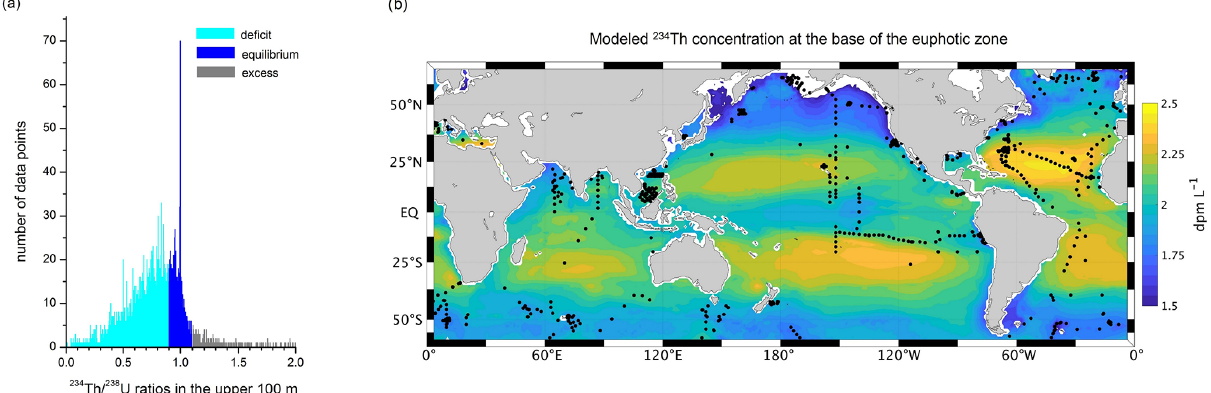
Figure 7. (a) Histogram of data points of 234 Th / 238 U ratios at 100 ± 10m of the water column. Ratios have been categorized as (i) “deficit”, (ii) “equilibrium”, and (iii) “excess” for those values where 234 Th concentrations are lower than, equal to, and larger than 238 U ones within 10% uncertainty. (b) 234 Th activities at the base of the regionally varying euphotic zone (defined here as the depth of the 0.1% light level) (Davidson et al., 2021). Black dotes indicate the observations near the euphotic zone that were used when producing the 234 Th concentration